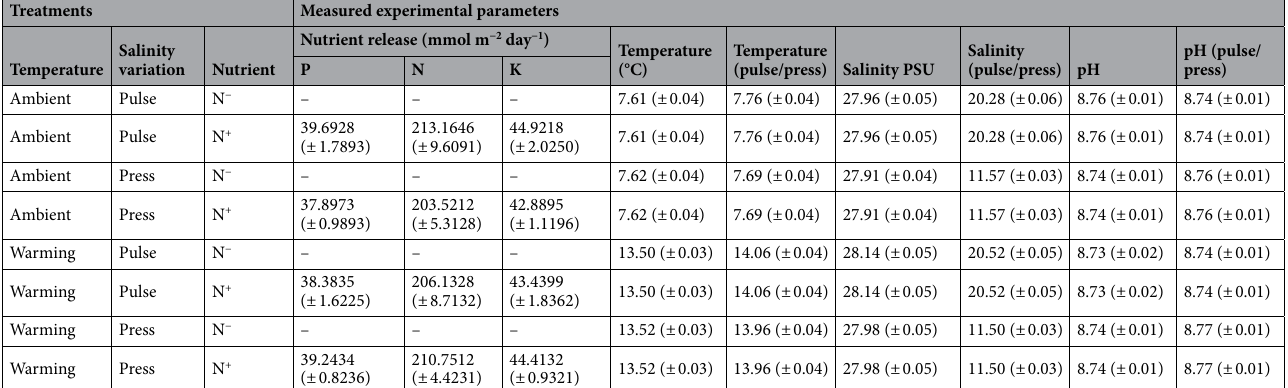
Table 1. Mean (± SE) values of experimental parameters measured or calculated in mixing tanks (temperature, salinity) or aquaria (nutrients) over the duration of the experiment for all treatments: phosphorus (P), nitrogen (N), and potassium (K) release (mmol m −2 d −1 ), temperature (°C), salinity (PSU) and pH during regular conditions and freshwater pulses and presses. Pulse treatments corresponded to periodical moderate drops of salinity six times per day: 9:00–9:30, 13:00–13:30, 17:00–17:30, 21:00–21:30, 01:0 0–01:30, 5:00–5:30. The press treatment corresponded to a single intense drop of salinity from 9:00 to